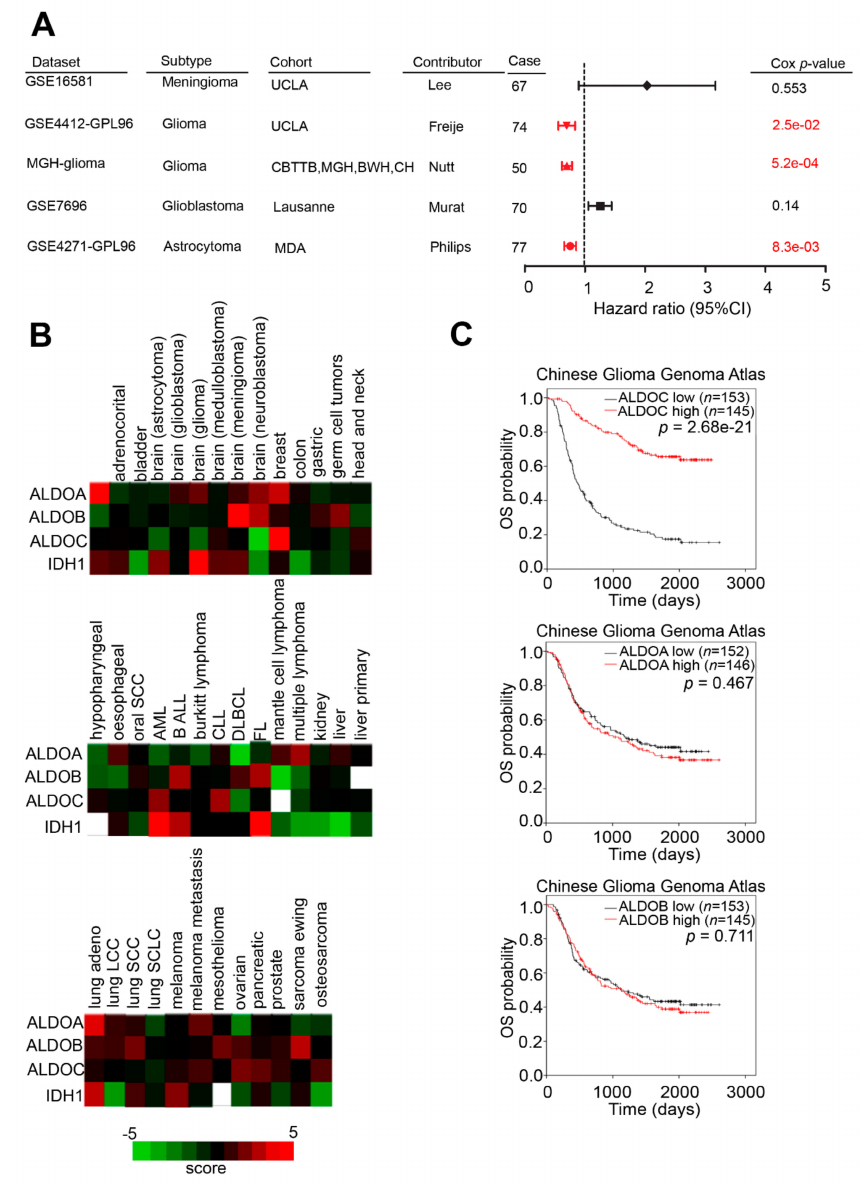
Figure 3. ALDOC mRNA expression associated with clinical features. ( A ) A forest plot showing hazard ratio and 95% confidence interval (CI) by ALDOC expression level in several clinical cohorts. ( B ) A heat map showing the endogenous mRNA expression level of IDH1 and the aldolase family members ALDOA, ALDOB, and ALDOC in various cancer subtypes from the PRECOG website ( n = 720). ( C ) Kaplan–Meier analysis of ALDOA, ALDOB, and ALDOC expression at concurrently low or high levels, with the endpoint of overall survival probability from the Chinese Glioma Genome Atlas in glioblastoma patients ( p = 711, p = 0.467, and p = 2.7 × 10 − 21 ,